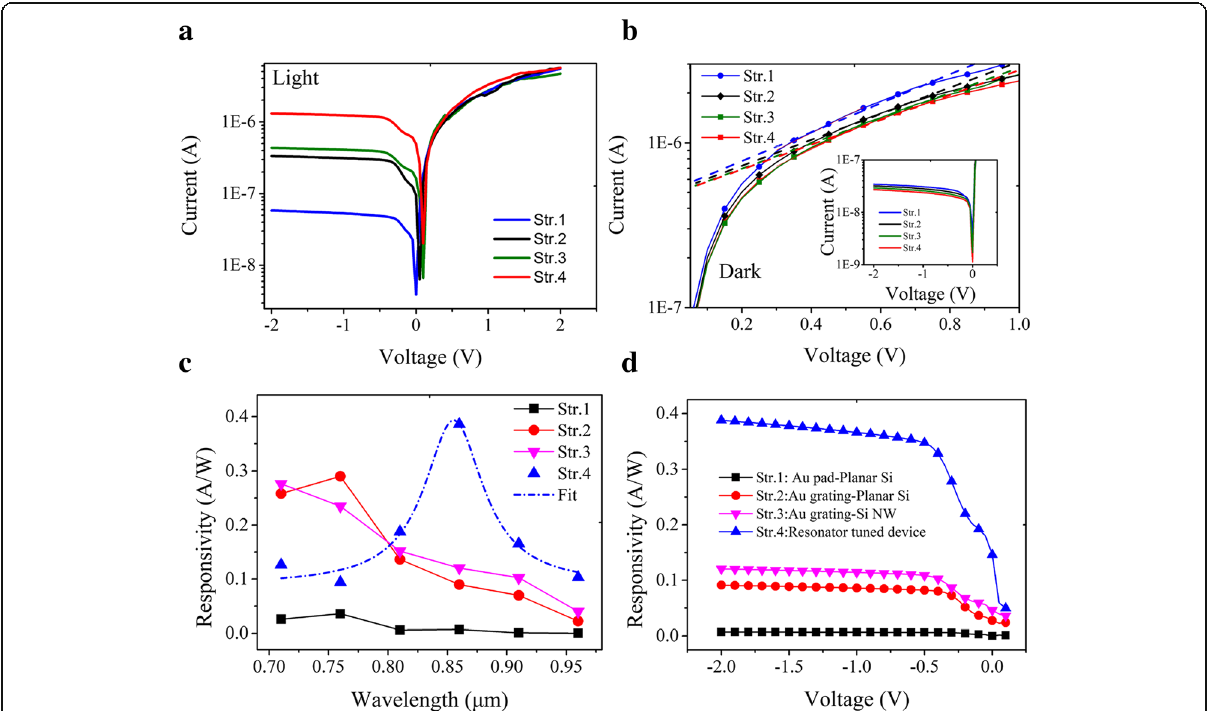
Fig. 5 The measurement results obtained from the fabricated all-silicon detector. a Light logarithmic I - V curves under the illumination intensity of 16.6 mW/cm 2 . b Dark logarithmic I - V curves. c Responsivity spectra under the bias of − 2 V and the light intensity of 16.6 mW/cm 2 . d Bias dependency of responsivity for 860 nm wavelength under the intensity of 16.6 mW/cm